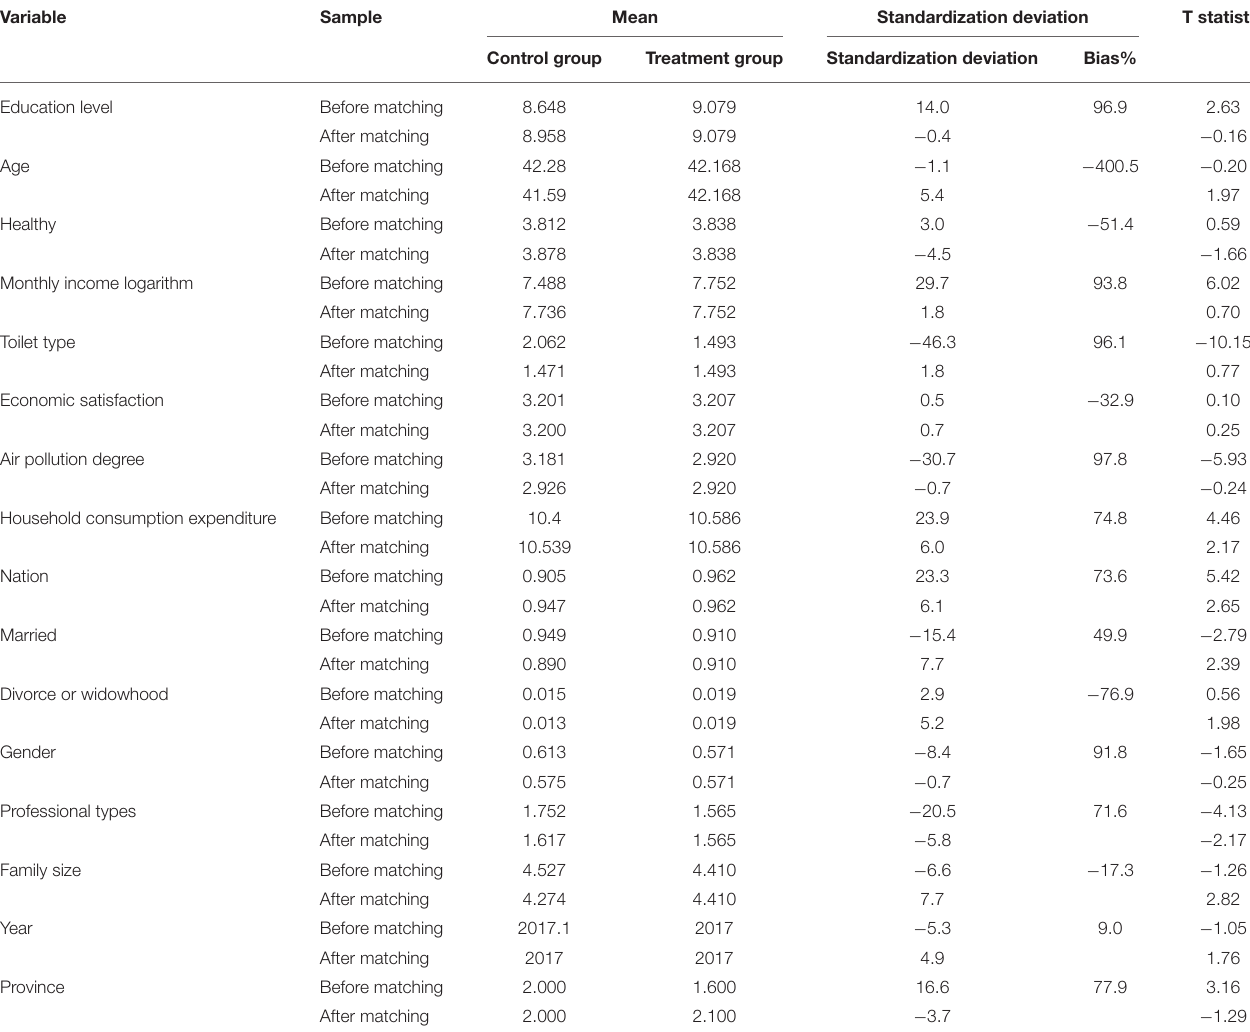
TABLE 4 | Balance test